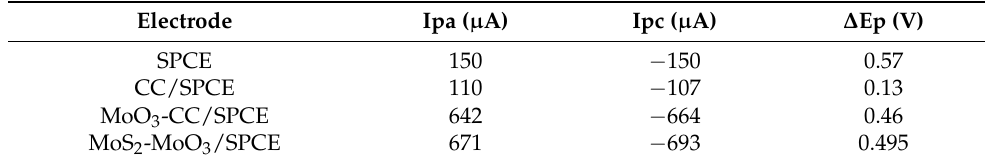
Table 2. CV data of anodic (Ipa) and cathodic (Ipc) current peaks and ∆ Ep for the bare SPCE and the modified CC/SPCE, MoO 3 CC/SPCE, and 2D-MoS 2 -MoO 3 CC/SPCE in 10 mM [Fe(CN) 6 ] 4– at a scan rate of 0.05 V/s.